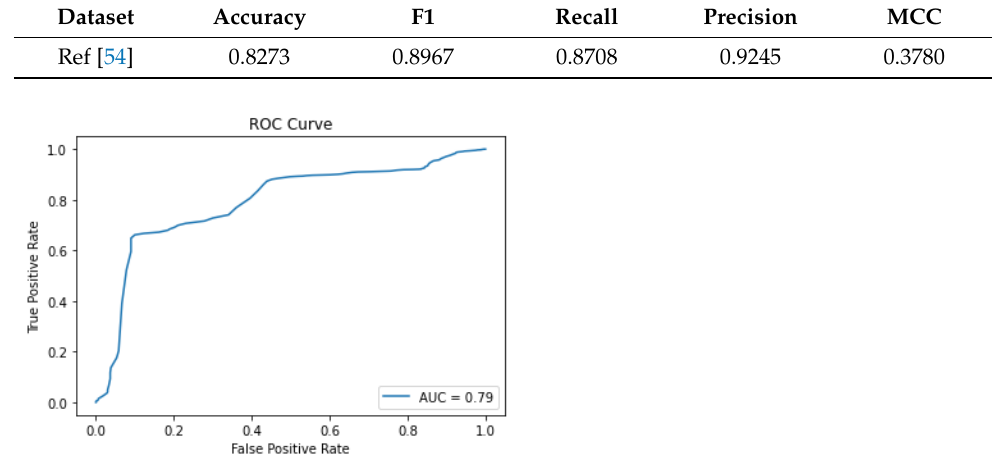
Figure 4. Receiver operating characteristic (ROC) curve for benchmark dataset using training/test with group 1 dataset.